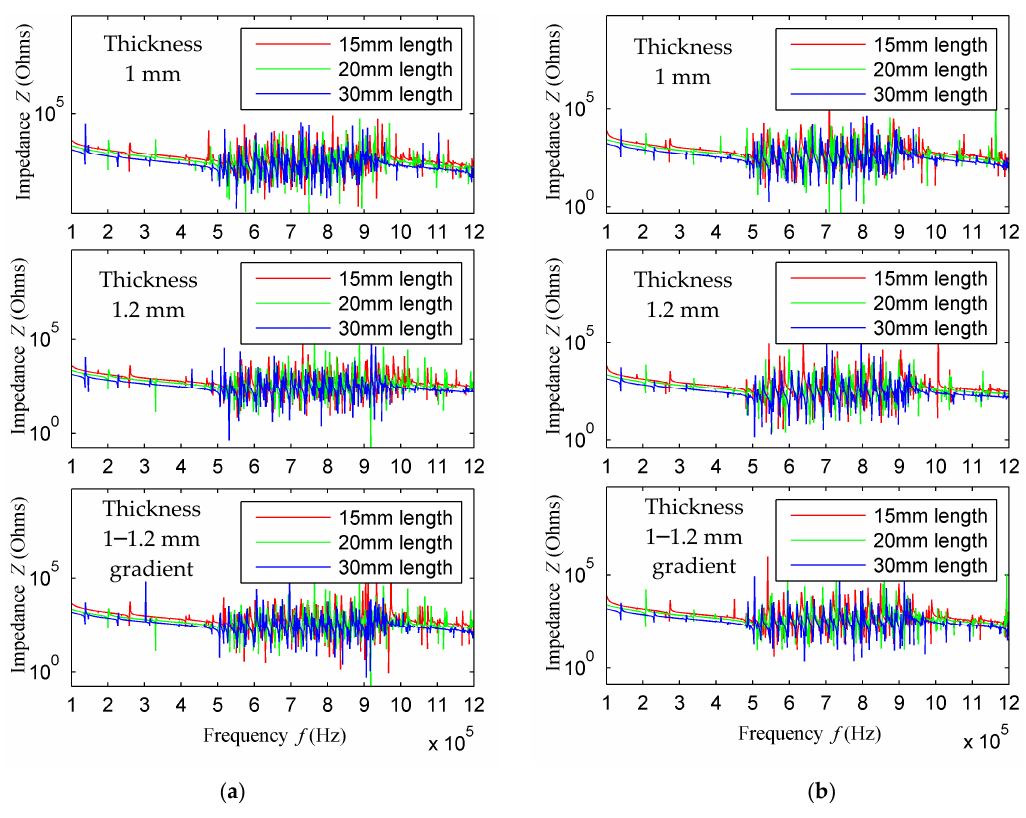
Figure 5. Impedance curves of array elements No. 1 and No. 2 with different array-element lengths and thicknesses: Impedance curves of ( a ) element No. 1 and ( b ) element No. 2.